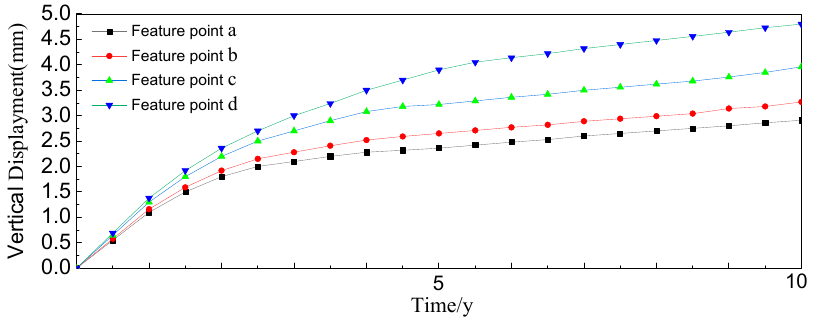
Figure 15. Settlement of each characteristic point when t = 10 years. Table 1. Canal top’s settlement rate.